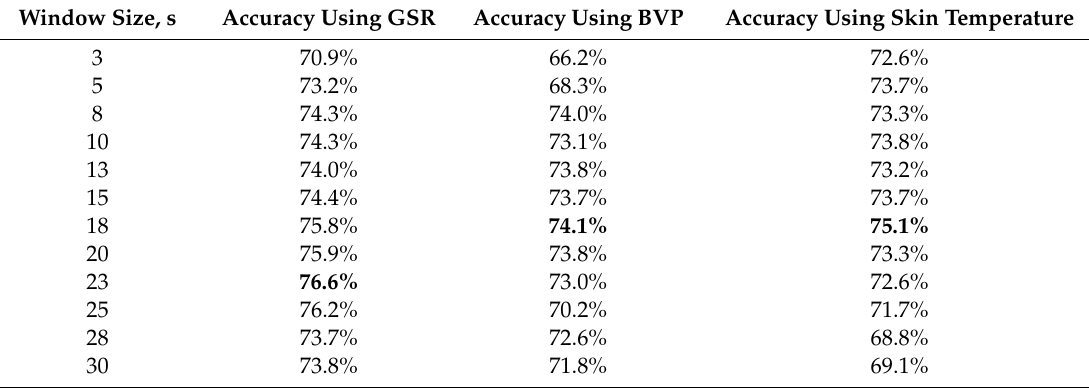
Table 2. Anxiety level prediction accuracy by signal type and window size (best results are shown in bold), 10 × 10 fold